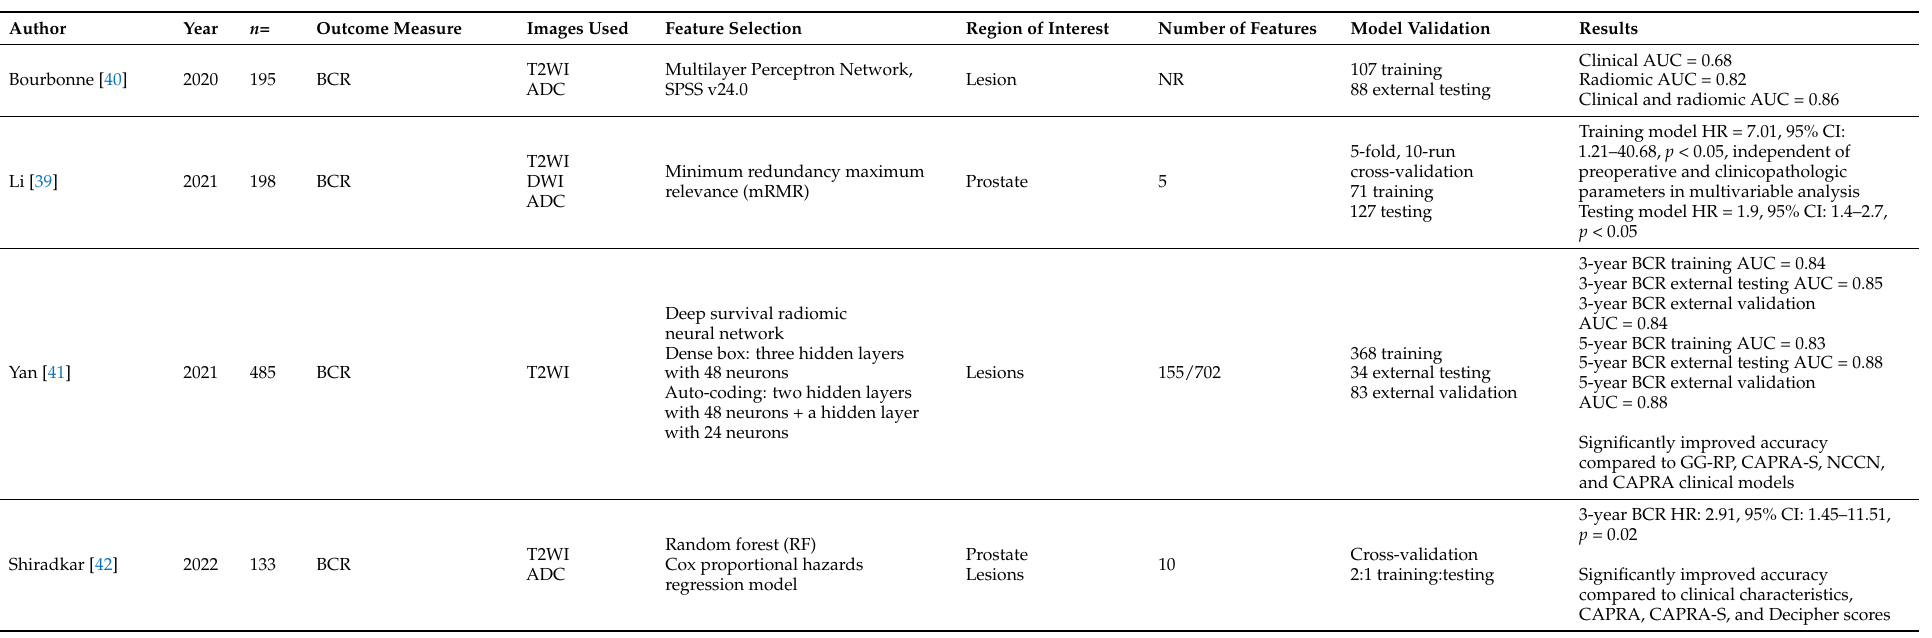
Table 3. Summary of studies utilizing MRI-derived radiomic models to predict biochemical recurrence following radical prostatectomy.